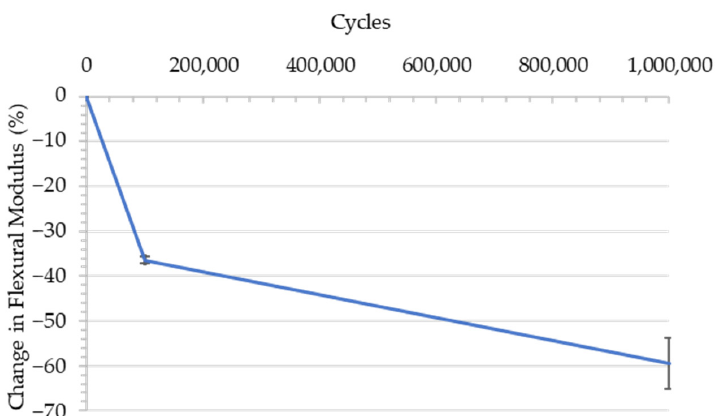
Figure 23. Rubber toughened CFRP after 100,000, with 1,000,000 cycles at 470 N flexural modulus loss graph .